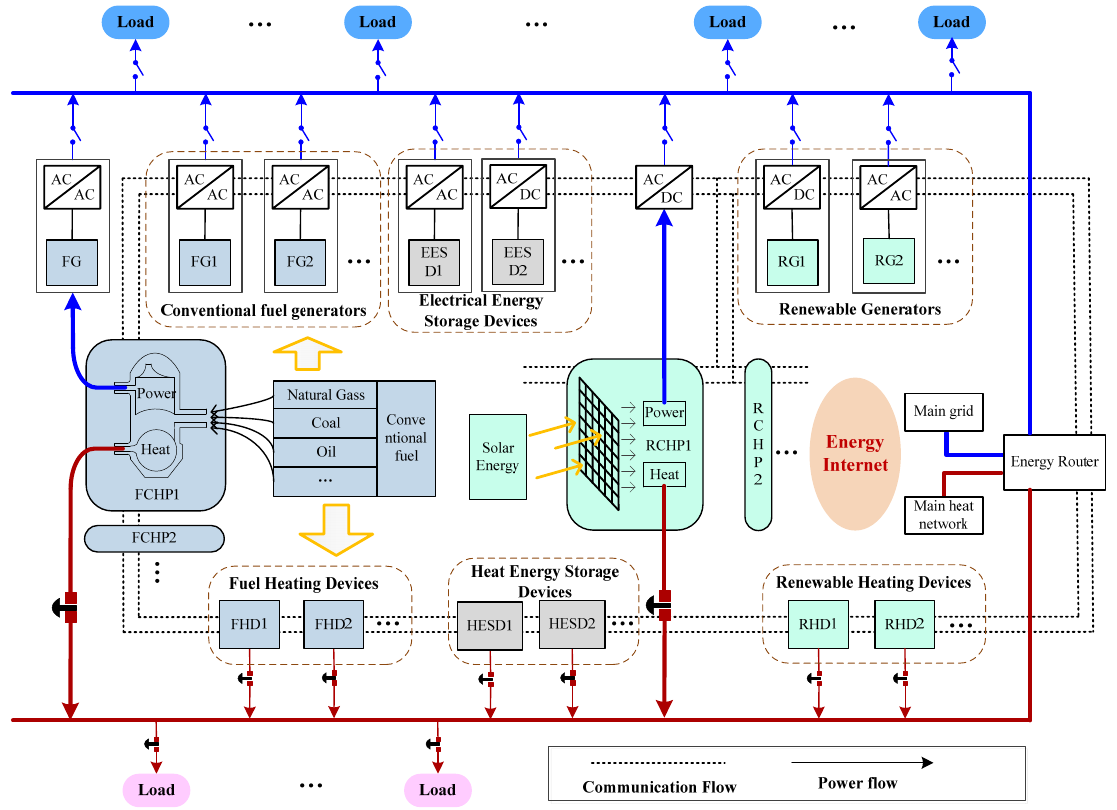
Figure 1. A structure of combined heat and power (CHP) system.